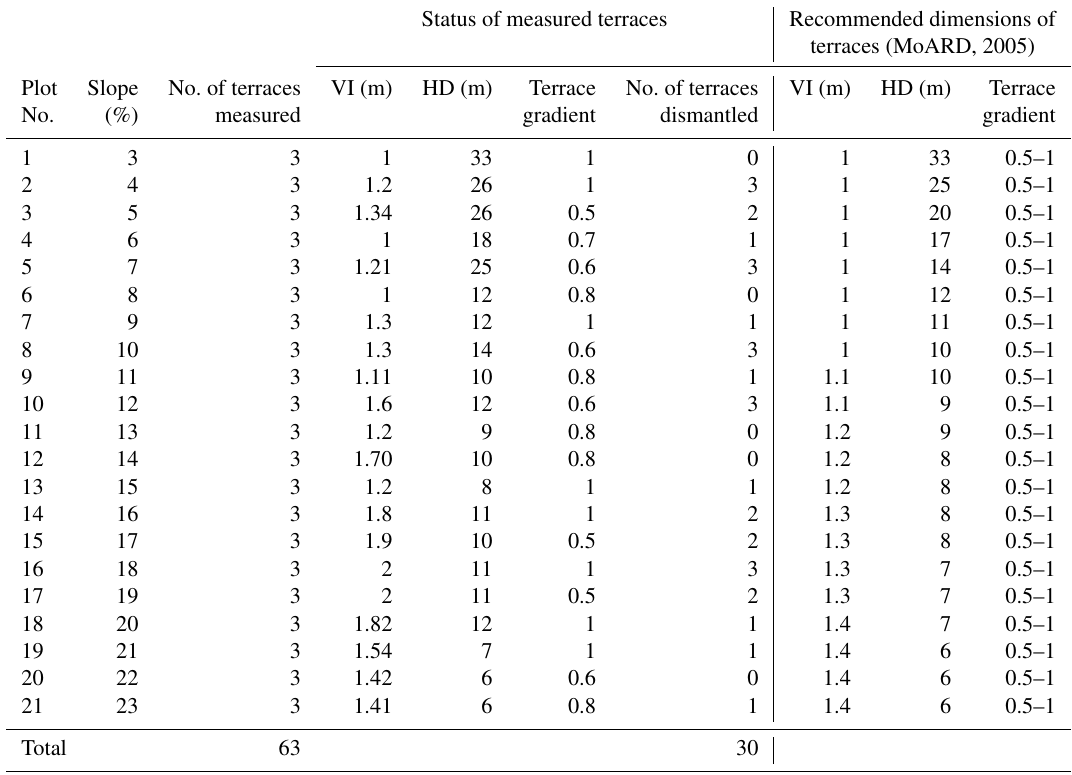
Table 5. Comparison of measured terrace structure parameters (VI, HD, gradient) based on the national terrace dimensions for different slope classes at selected farm plots of the study site.